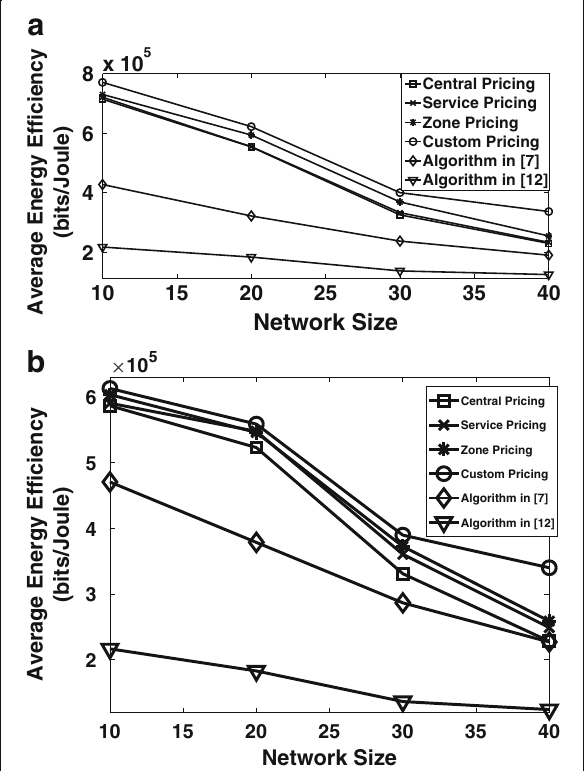
Fig. 4 Average energy efficiency versus the number of users requesting a inelastic and b elastic services considering the RP framework and comparative scenarios